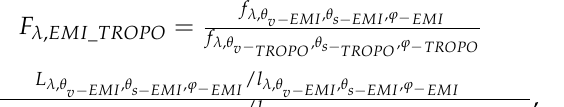
Figure 8. Comparison of spectral adjustment factors.